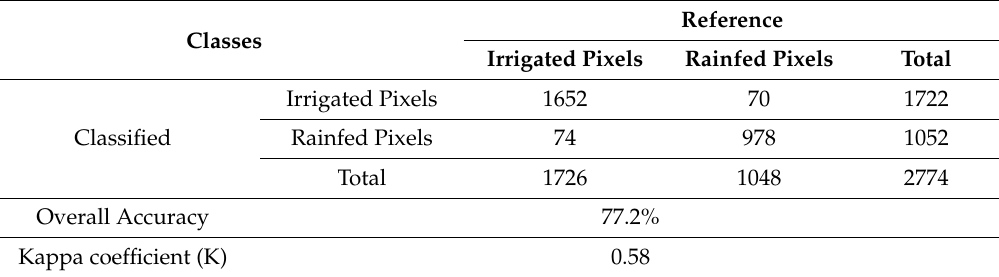
Table 4. Classification accuracy when the soil moisture is assessed.